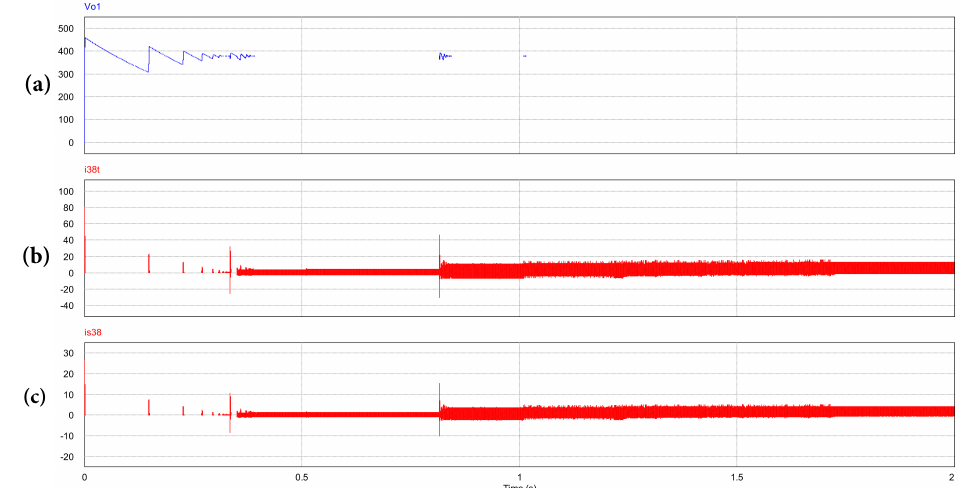
Figure 33. Sixth set of simulation results, ( a ) primary DC bus, ( b ) total current from three boost converters array and ( c ) boost converter number one output current.